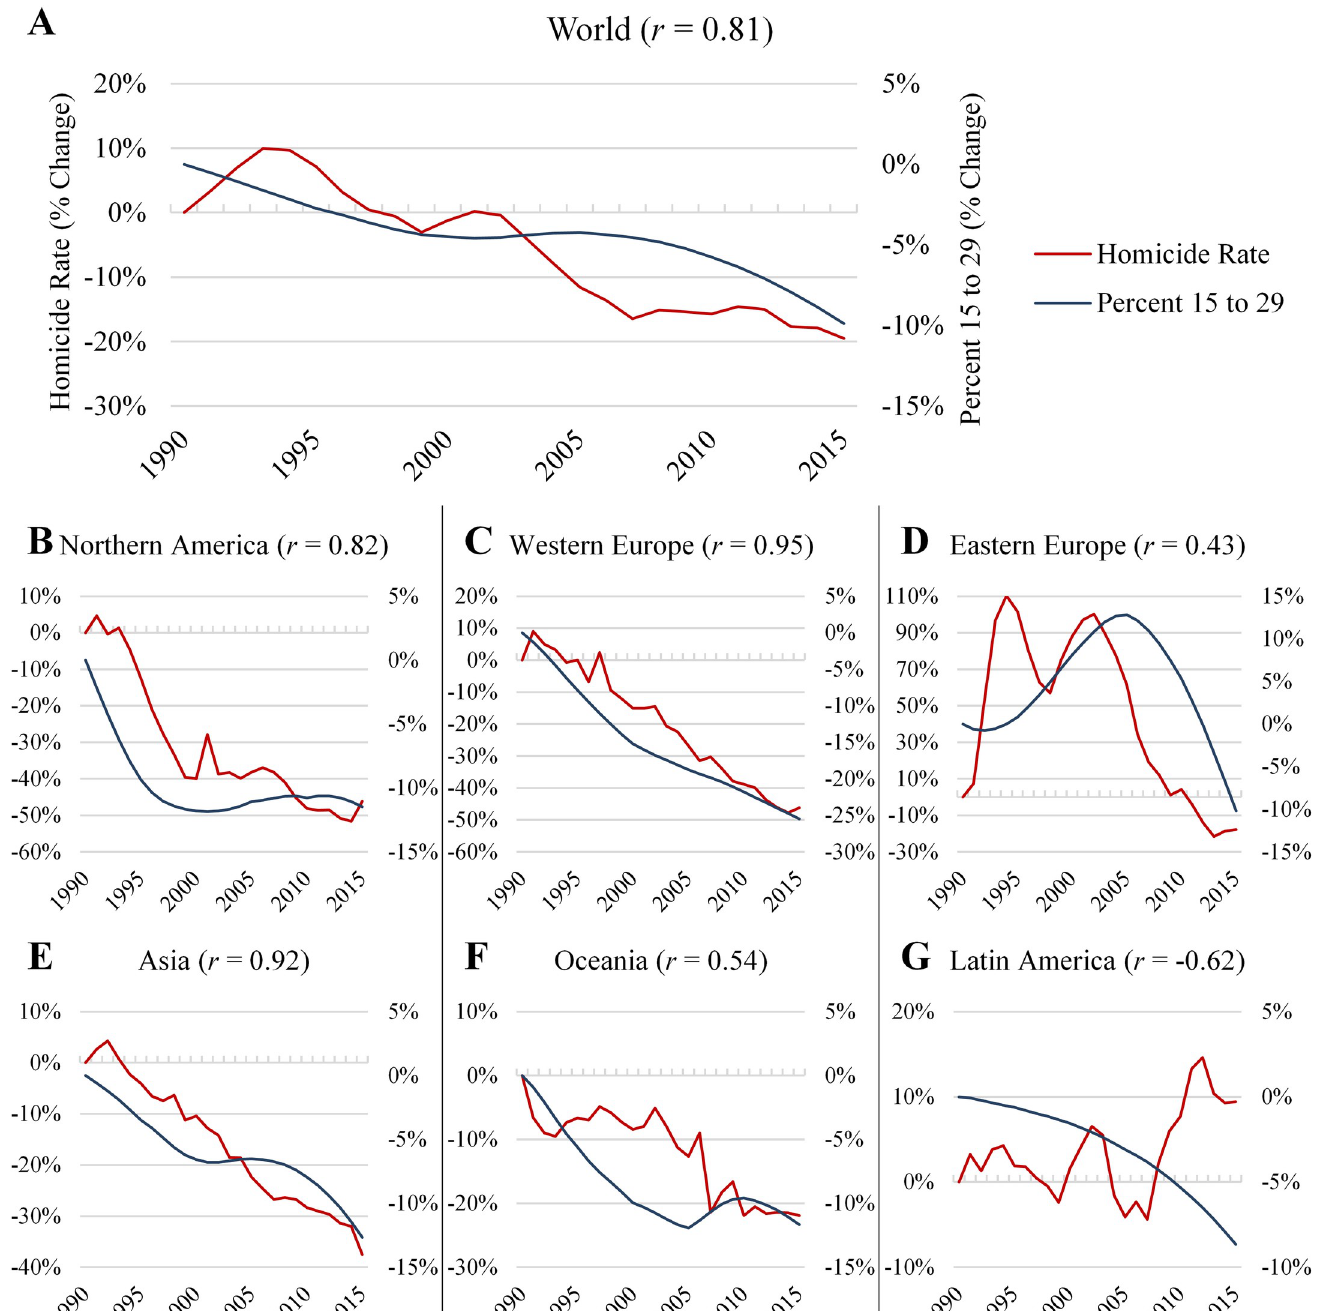
Fig 5. Percent change from 1990 in the homicide rate and percent of Population 15 to 29 by region– 1990 to 2015. Shown is the percent change in homicide rate and in the percent of the population 15 and 29 for each year relative to 1990, until 2015. The percent change in the percent 15 to 29 is in the secondary axis. The Pearson correlation between the two series is in parenthesis. Each region is in a part of the figure. Africa is omitted due to lack of data representing the entire region. (A) Global Trend. (B) Northern America. (C) Western Europe. (D) Eastern Europe. (E) Asia. (F)